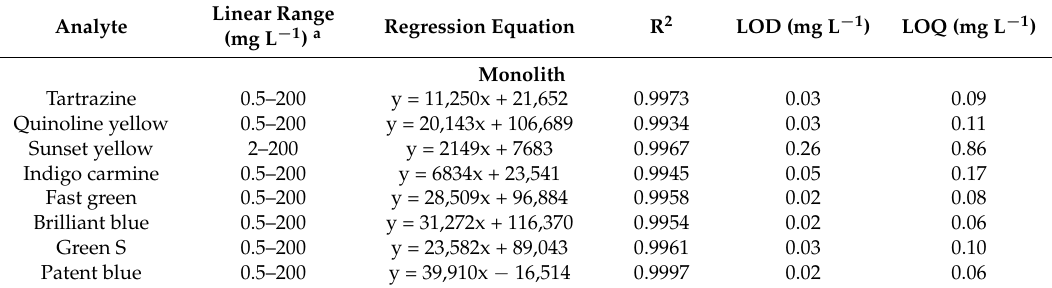
Table 2. The analytical characteristics of the developed method in comparison of two types of